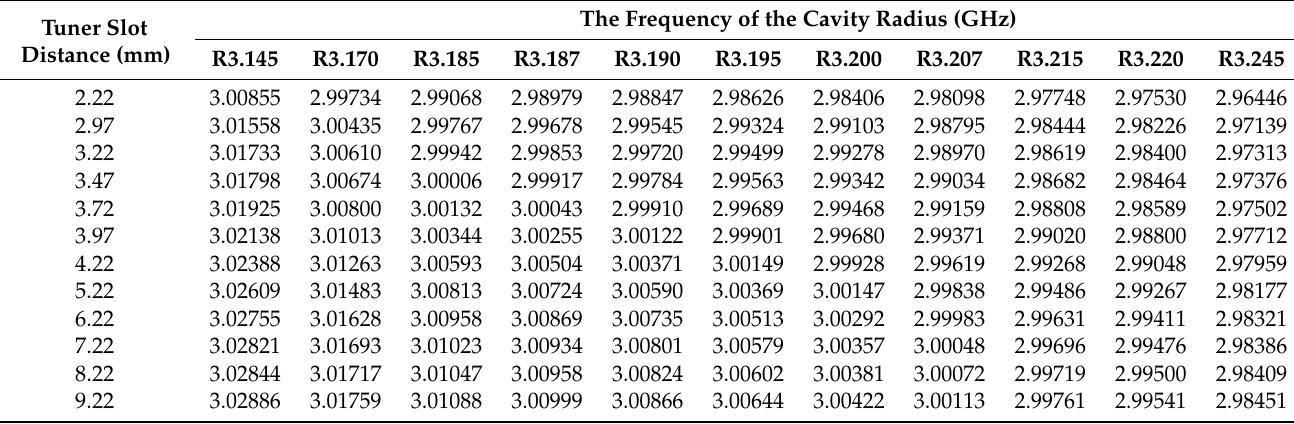
Table 6. Simulation results of the resonant frequency by the equivalent circuit